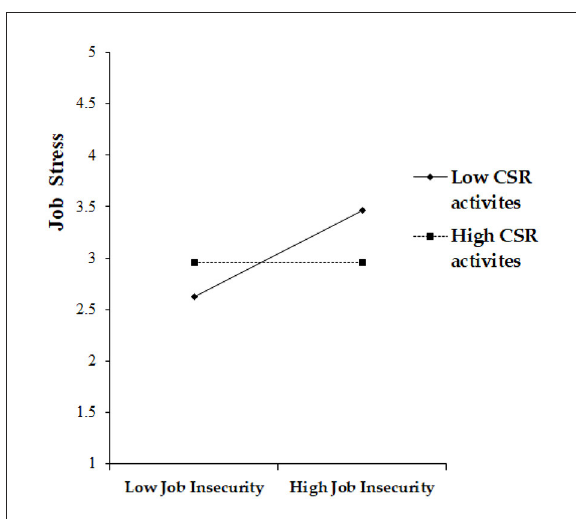
FIGURE3 Moderating effect of CSR in the job insecurity–Job stress link.